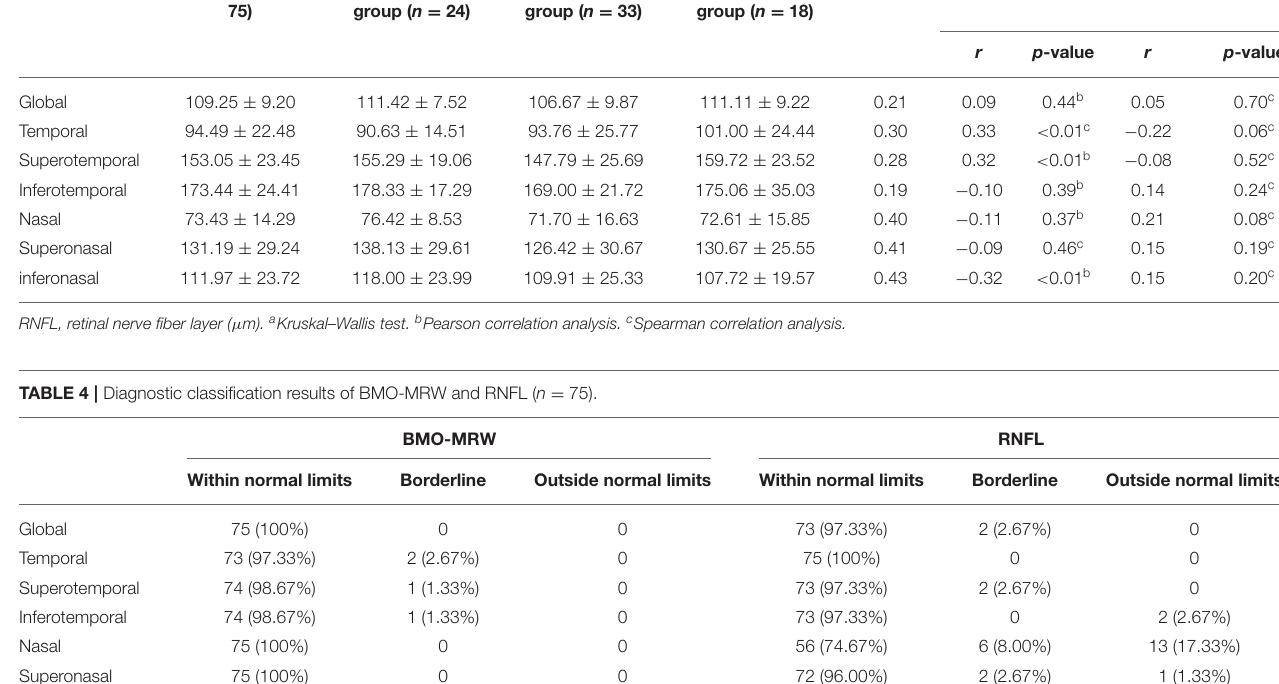
TABLE 3 | Correlations between RNFL thickness and axial length/spherical equivalent. p -value a Axial length Spherical equivalent All groups ( n = Low myopic Middle myopic High myopic 75) group ( n = 24) group ( n = 33) group ( n = 18)